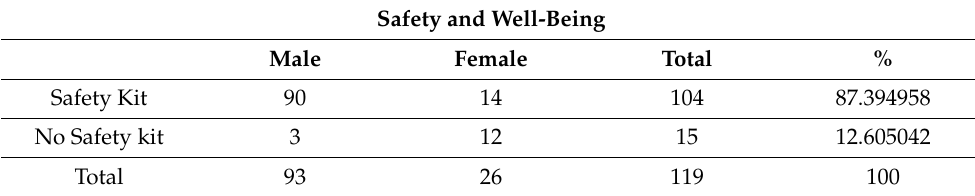
Table 2. Hazards experienced during waste picking.